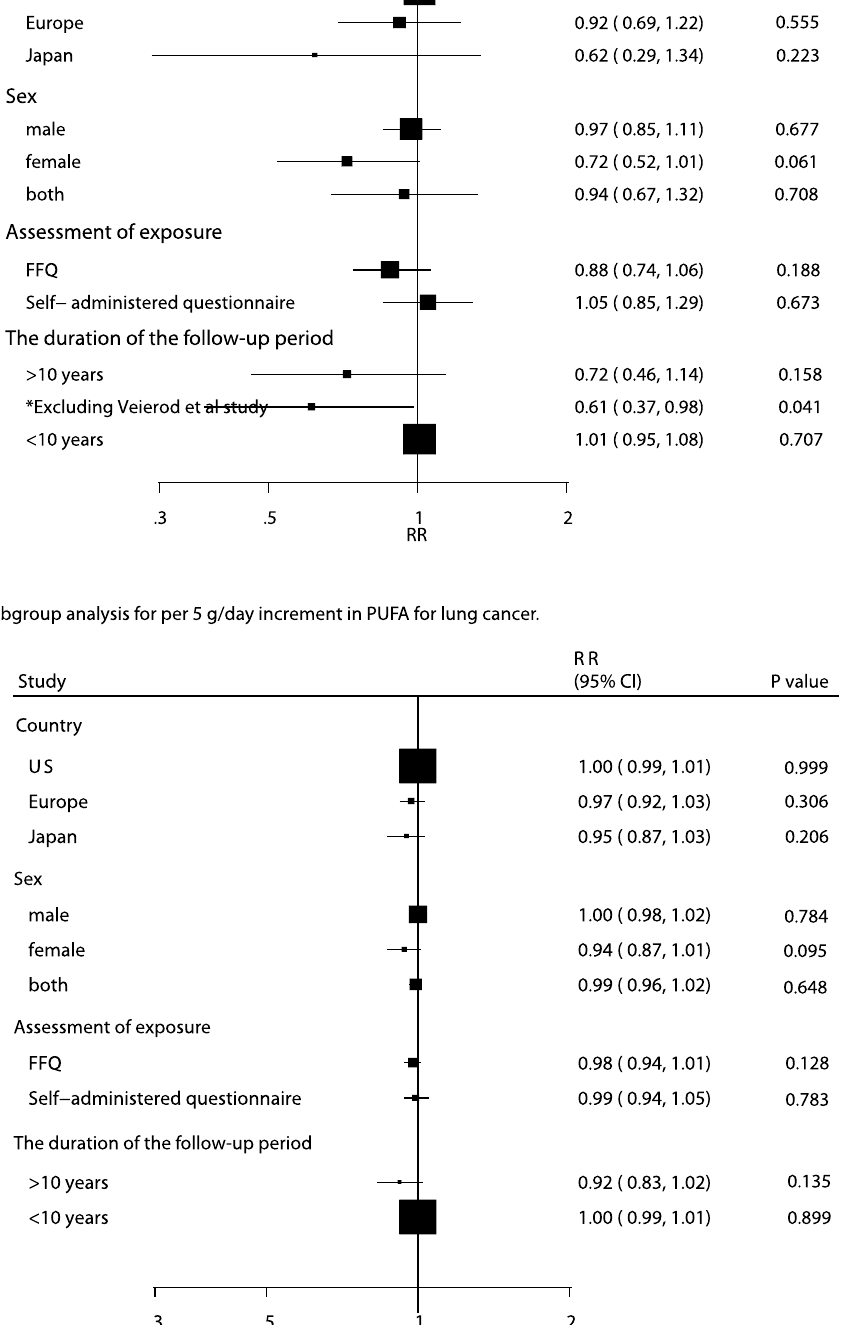
Figure 4. Subgroup analysis for high versus low PUFA intake for lung cancer (A); Subgroup analysis for per 5 g/day increment in PUFA intake for lung cancer (B).